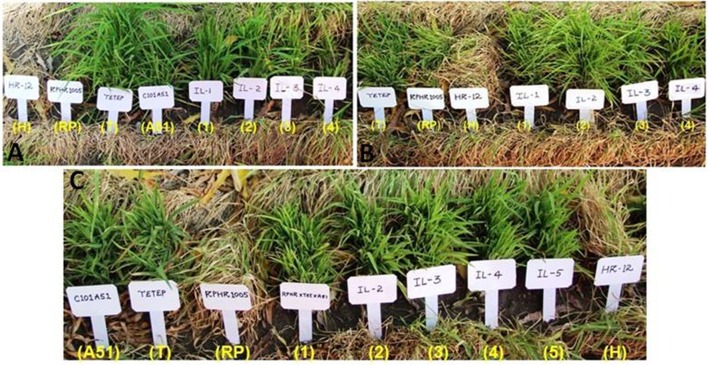
Phenotypic screening of the selected improved and double intercrossed lines against rice blast disease. (A) Screening of the selected IC1F5 lines (Xa21 + Pi2 + Pi54) against blast disease following UBN Method. All the intercross derived lines IL-1 to IL-4 (RPIC1-12-196-12, RPIC1-12-196-15, RPIC1-12-196-36, and RPIC1-12-196-45) were highly resistant. (B) Screening of selected IC2F5 lines (Xa21 + Xa33 + Pi54) against blast disease following UBN Method. All the intercross derived lines IL-1 to IL-4 (RPIC2-53-640-6, RPIC2-53-640-18, RPIC2-53-640-35, and RPIC2-53-640-43) were highly resistant. (C) Screening of selected DICF3 lines (Xa21 + Xa33 + Pi2 + Pi54) against blast disease following UBN Method. (A51) C101A51- Resistant check; (T) Tetep- Resistant check; (RP) RPHR-1005- Recurrent parent (susceptible), (H) HR-12- Susceptible check and all the double intercross derived lines IL-1 to IL-5 (RPDIC-9-786-1, RPDIC-9-786-19, RPDIC-9-786-25, RPDIC-9-786-46, and RPDIC-9-786-78) were highly resistant.